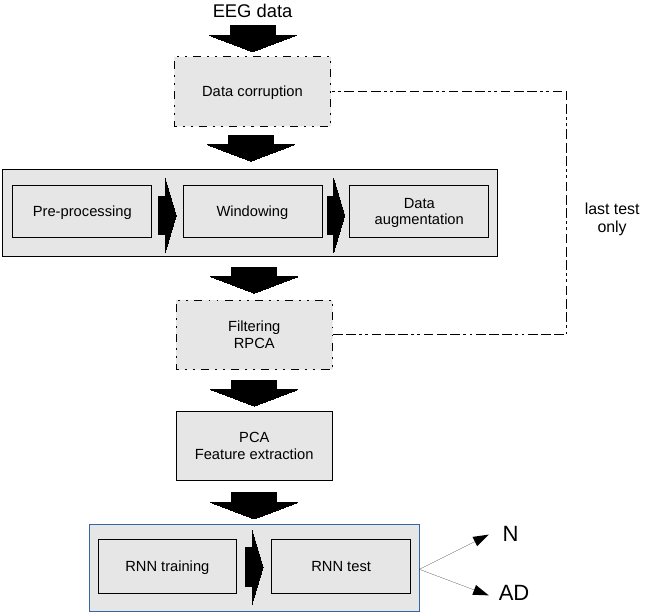
Figure 3. Flow chart of the proposed algorithm for Alzheimer’s disease